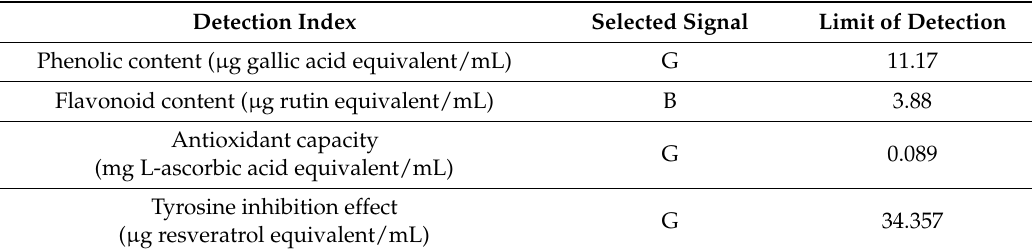
Figure 11. Signal values in R, G, and B channels for different levels of phenols ( a ), flavonoids ( b ), antioxidant capacity ( c ), and tyrosinase inhibition effect ( d ). Table 3. Limit of detection (signal/noise = 3) for multi-assay of fruit